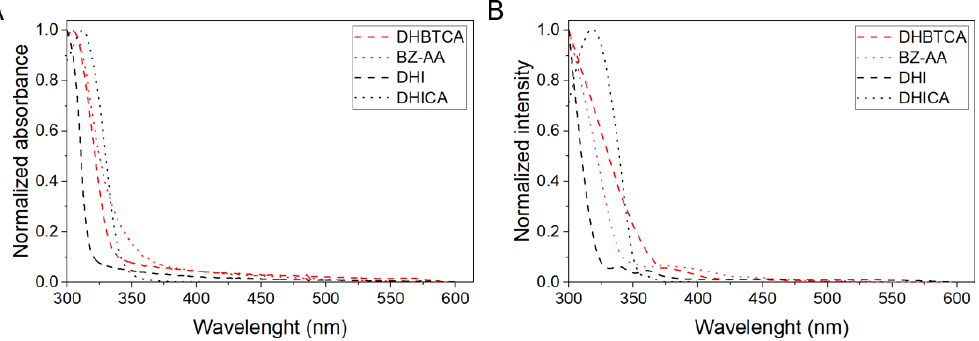
Figure 8. Normalized UV-Vis absorption spectra ( A ) and action spectra of singlet oxygen photogeneration ( B ) for melanin monomers.